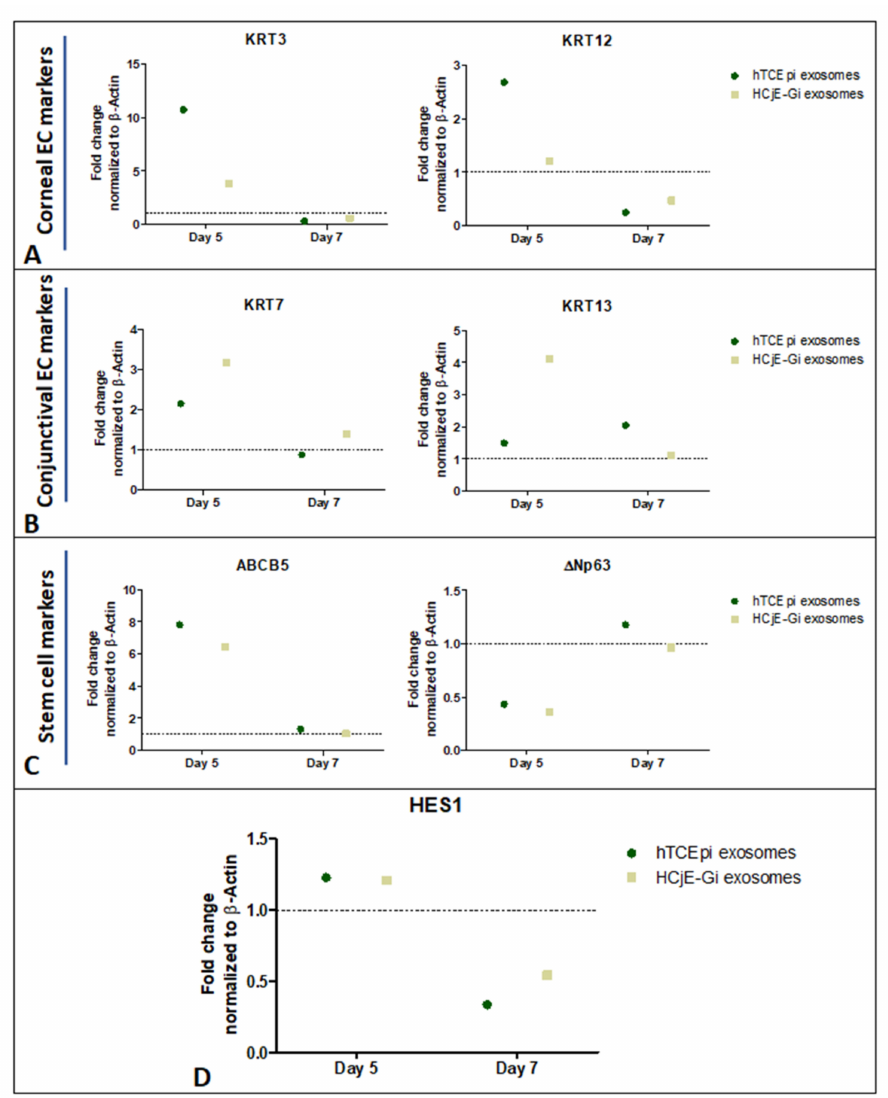
Figure 6. Ex vivo study on human cadaveric donor tissues following treatment with HCjE-Gi and hTCEpi cell-derived EVs. Overexpression of ( A ) KRT3 and KRT12 at day 5, ( B ) KRT7 and KRT13 at day 5 and day 7 and ( C ) ABCB5 at day 5 and ∆ Np63 at day 7 following treatment with only hTCEpi cell-derived EVs. ( D ) HES-1 was overexpressed at day 5. ( n = 1 for each time